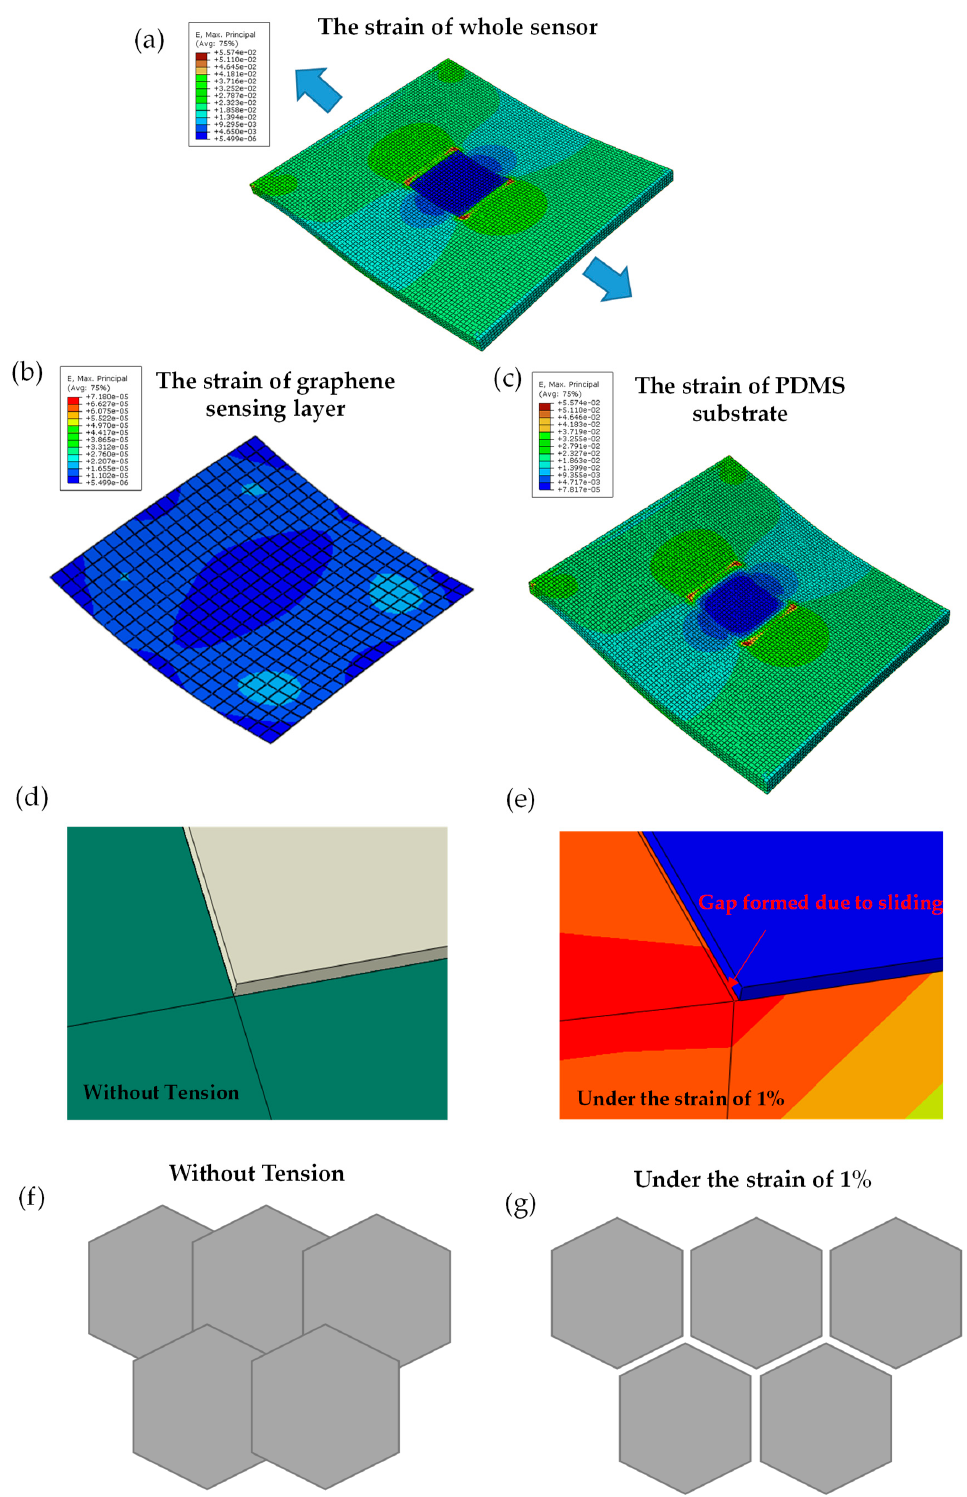
Figure 4. The finite element method (FEM) simulation analysis of the slip of graphene sheets when the substrate is under uniaxial stretching. ( a ) The strain distribution of the sensor ( b ) and ( c ) is the strain simulation of graphene sheet and PDMS substrate respectively; ( d ) the relative movement of the graphene sheet with substrate before stretching and ( e ) after stretching; ( f ) the schematic microscopic stacking of graphene sheets before stretching and ( g ) after